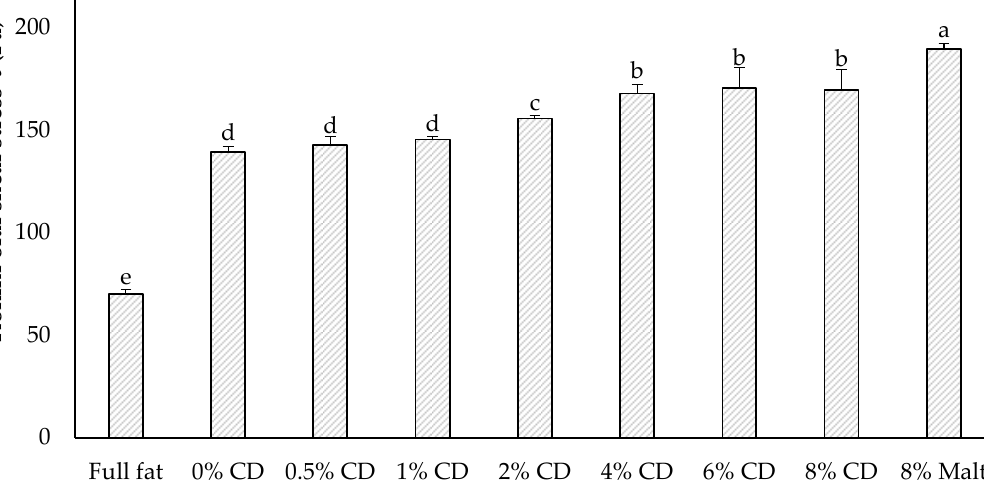
Figure 1. The Kokini OSS of all mayonnaise formulations. The data are expressed as mean ± standard deviation ( n = 9). Bars with different letters indicate significant differences between samples ( p < 0.05) following one-way ANOVA (Tukey).